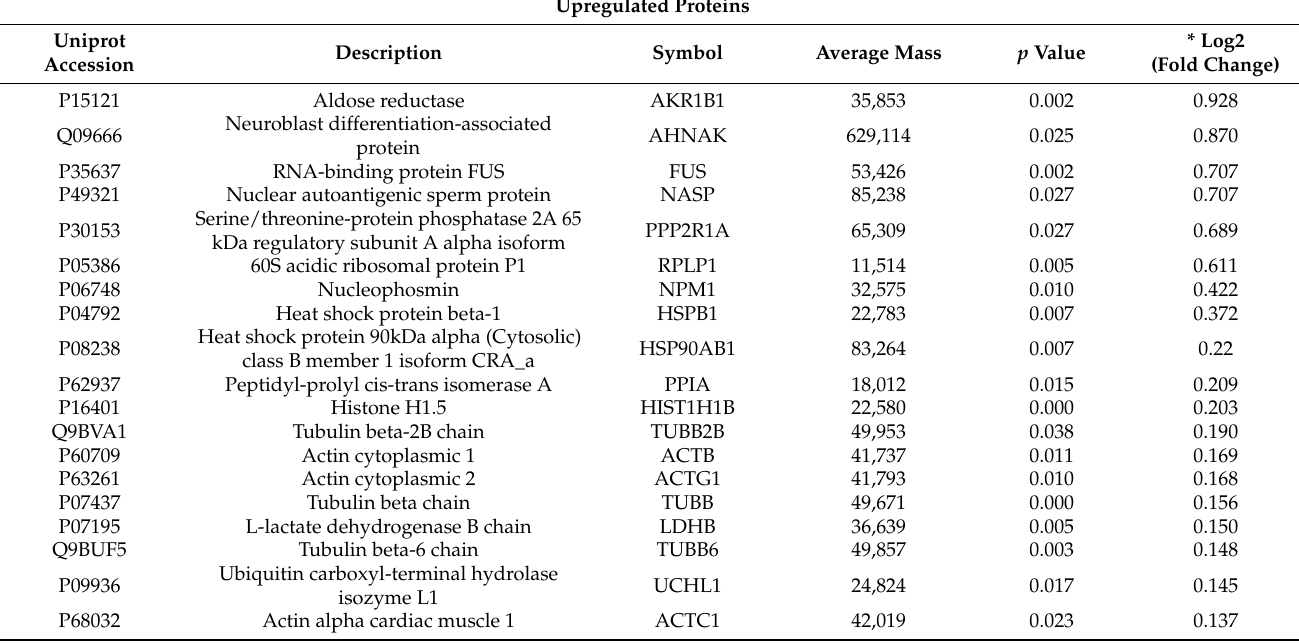
Table 2. Differentially expressed total protein extract from levodopa-treated diff-neural cells com- pared to untreated